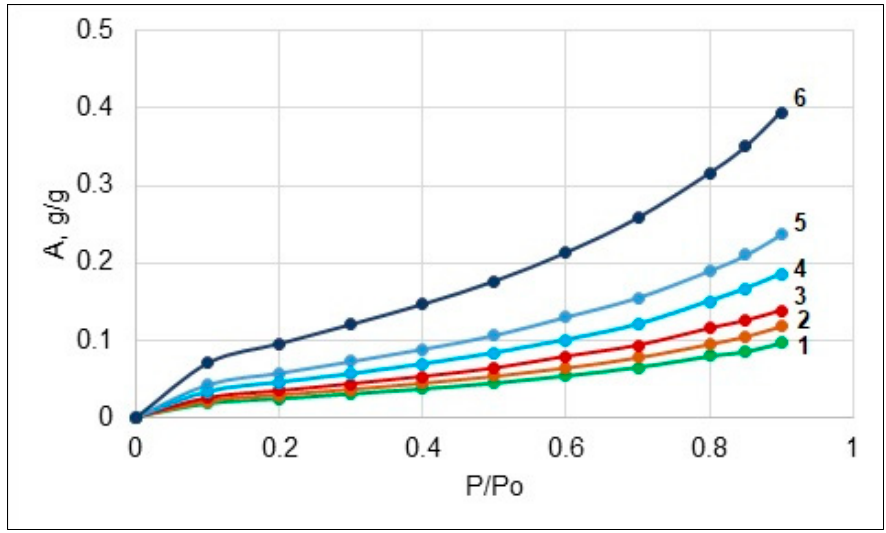
Figure 3. Sorption isotherms of water vapor (WV) for samples of MCC (1), CC (2), SP (3), SPM (4), VF (5), and AC (6).